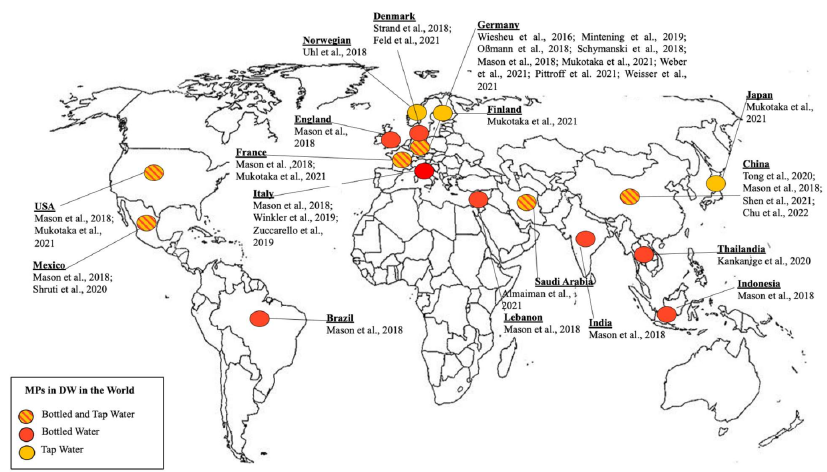
Figure 3. Geographical representation of MPs data in drinking water. TW: Tap Water; BW: bottled